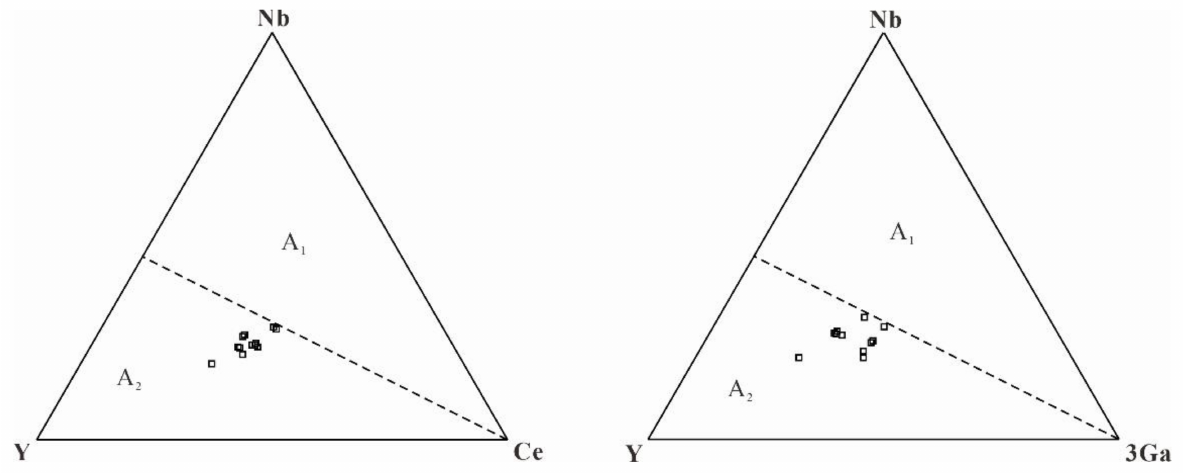
Figure 10. Triangle diagrams for distinguishing group A 1 and group A 2